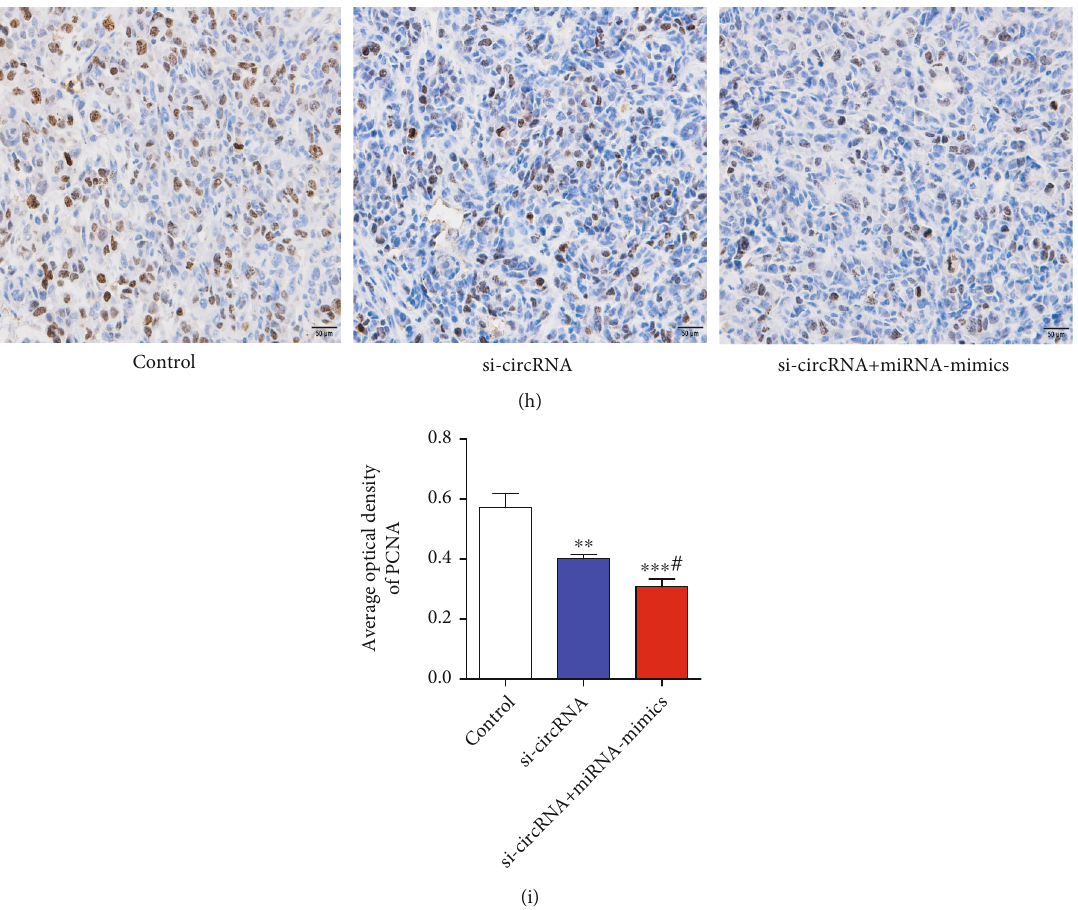
Figure 6: hsa_circ_0000511 promotes EMT of cervical cancer cells in vivo by downregulating hsa-miR-296-5p/HMGA1. Inhibition of hsa_ circ_0000511 signi fi cantly reduced the tumor volume in vivo (a, b), and Western blot analysis (c) showed that the protein expression of HGMA1 was decreased in turn when hsa_circ_0000511 was silenced or hsa-miR-296-5p was activated (d), while the protein expression ration between E-cadherin and N-cadherin was opposite to that of HGMA1 (e). Meanwhile, the results of qRT-PCR showed that the expression of hsa_circ_0000511 was consistent with the protein expression of HGMA1 (f) but the expression of hsa-miR-296-5p (g) was opposite to that of hsa_circ_0000511. Besides, changes of average optical density of PCNA (h, i) were consistent with the expression of hsa_circ_0000511. Mean ± SD ; the data were analyzed by one-way analysis of variance; vs. the control, ∗∗ p < 0 : 01 and ∗∗∗ p < 0 : 001 ; vs. si-circRNA, # p < 0 : 05 , ## p < 0 : 01 , and ### p < 0 : 001